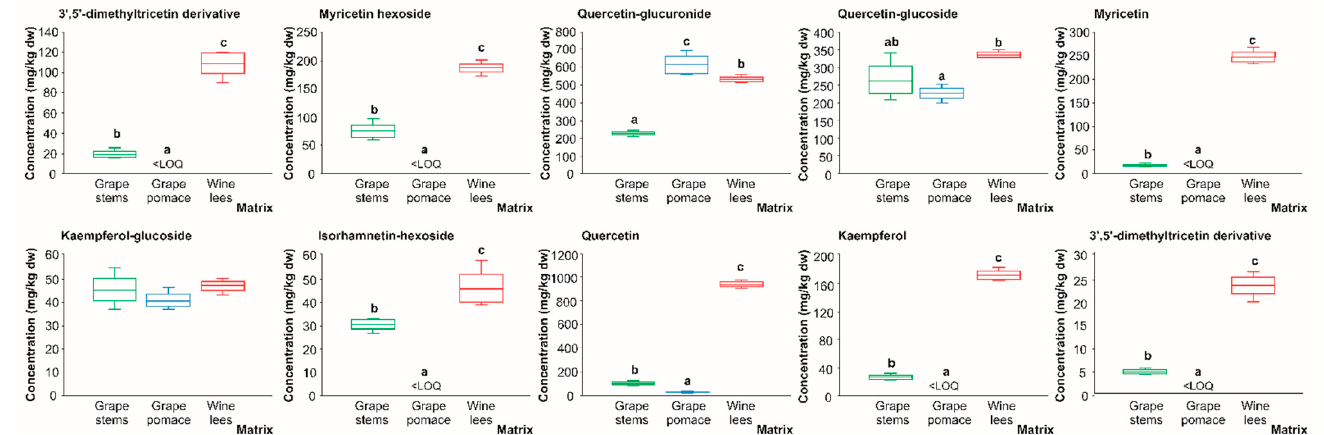
Figure 9. Box plots with quartiles (upper values 75%, median 50%, and lower values 25%) of individual flavonols (mg/kg dw) of (poly)phenolic extracts of grape stems (green box), grape pomace (blue box), and wine lees (red box). Boxes with a different letter (a,b,c) within each plot indicate statistically significant differences ( p < 0.05) according to the analysis of variance (ANOVA) and Tukey’s multiple range test. <LOQ, lower than the limit of quantification.